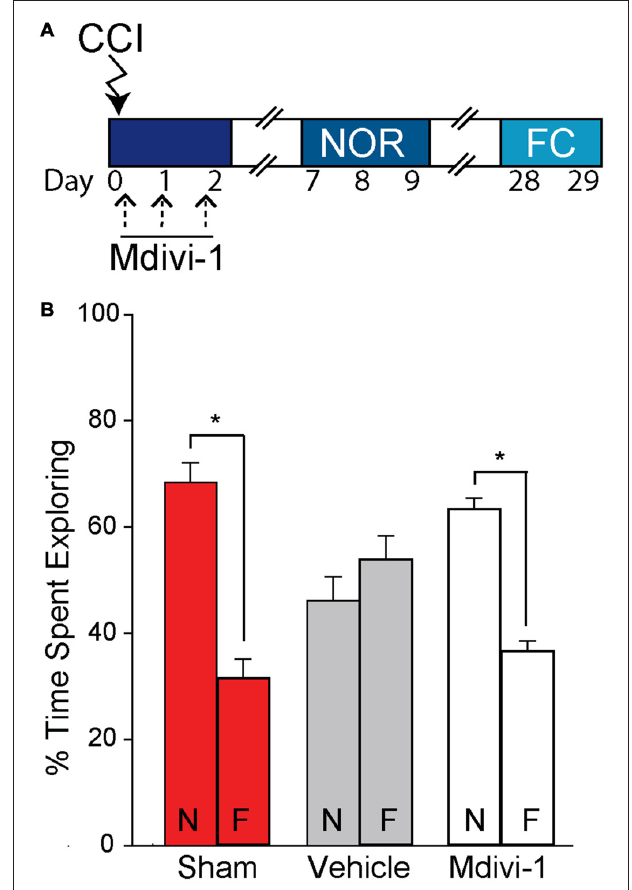
FIGURE 5 | Post-CCI mdivi-1 treatment rescues recognition memory after CCI injury. CCI animals were treated with either 3.0 mg/kg of Mdivi-1 ( n = 8) or vehicle ( n = 6) starting 30 min post-injury, and subsequently at 24 and 48 h post-injury. (A) Representative timeline for Mdivi-1 treatment and behavioral experiments. Rats were familiarized with two identical objects during the training period and percent of time spent exploring each object was quantified to control for any pre-existing biases. No significant biases to either object were observed. (B) Twenty-four hours later, one of the objects was replaced by a novel object and percent of time spent exploring both the novel (N) and familiar (F) objects were recorded. Mdivi-1 treated animals demonstrated improved recognition memory in the Novel object recognition (NOR) task indicated by a significant increase in exploration of the novel object vs. the familiar object. Data are presented as the mean ± SEM. ∗ p < 0.05. CCI, controlled cortical impact; FC, fear conditioning; NOR, novel object